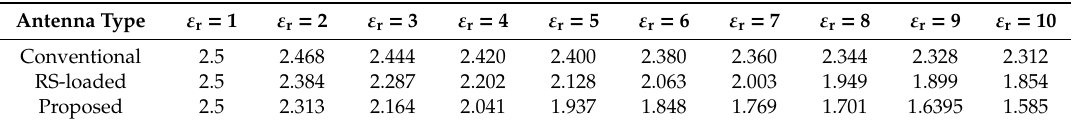
Figure 4. S 11 characteristics for varying relative permittivity of the material under test (MUT): ( a ) conventional MPSA; ( b ) RS-loaded MPSA; and ( c ) proposed MLS-loaded MPSA. Table 1. First resonant frequencies of S 11 responses of the conventional, RS-loaded, and proposed MLS-loaded MPSAs in GHz.